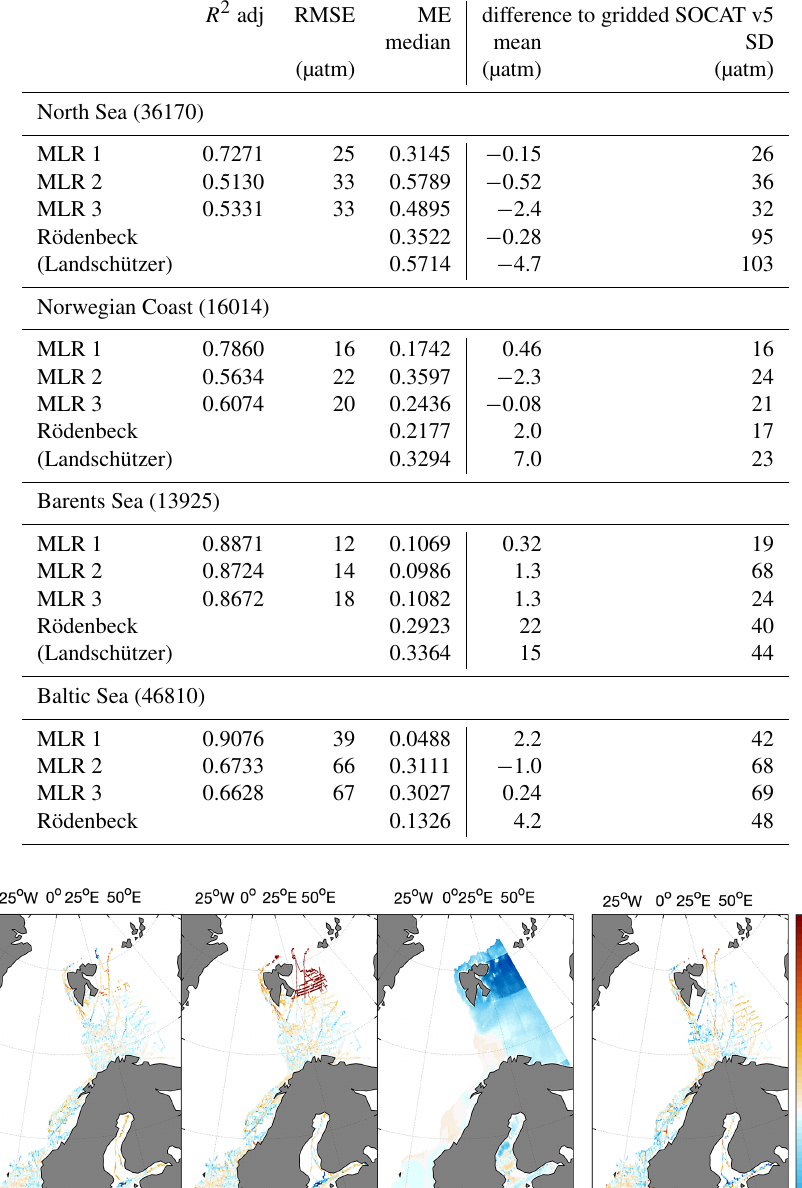
Table 5. Statistical evaluation of the MLR 1, MLR 2 and MLR 3 in comparison to the open-ocean maps of Rödenbeck et al. (2015) and Landschützer et al. (2017) for each region. The data for the open-ocean map of Landschützer et al. (2017) are in parentheses since this is based on an extrapolation of the nearest open-ocean grid cell towards the coast. The number of grid cells containing data is given behind the region abbreviations.